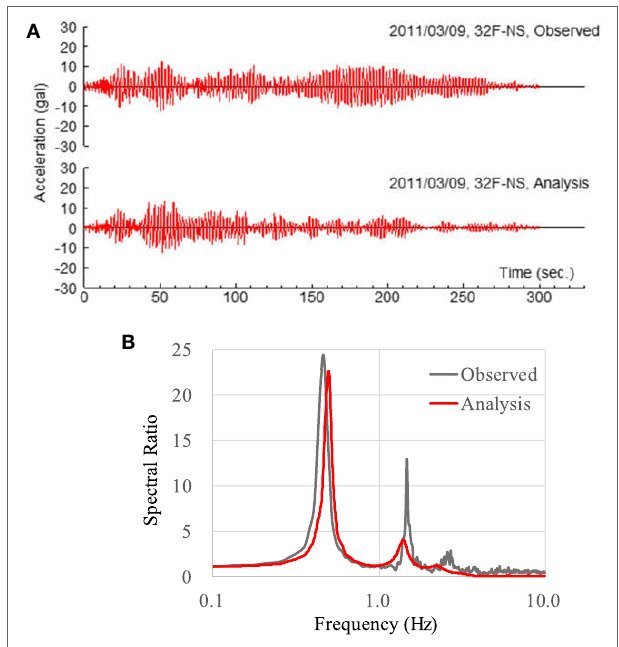
FigUre 8 | Comparison of observed and analytical response for the 3/9 pre-shock (N–S direction): (a) acceleration waveforms for 32F, (B) transfer function between 32F and ground level.